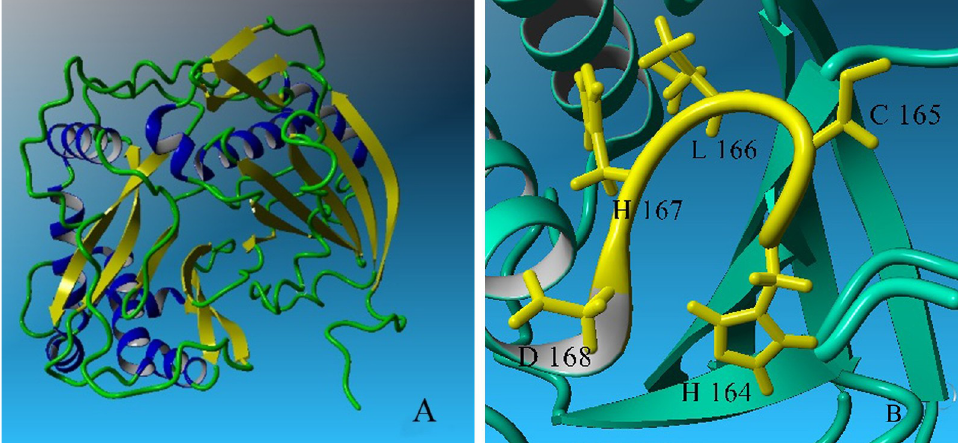
Fig 7. 3D-structure of the T5AT enzyme presented by YASARA program. (A) Beta-strands and alpha-helixes are yellow and blue, respectively. This model has 15 beta-strands and 9 alpha-helices; (B) HXXXD motif in T5AT enzyme contains His 164, Cys 165, Leu 166, His 167 and Asp168.